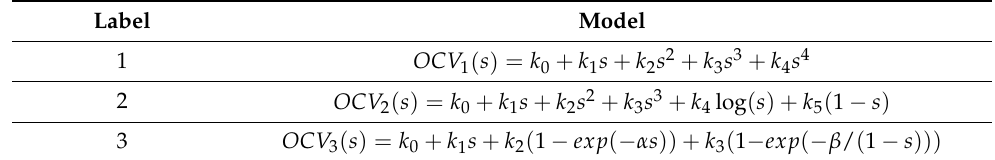
Table 4. Conventional OCV models.